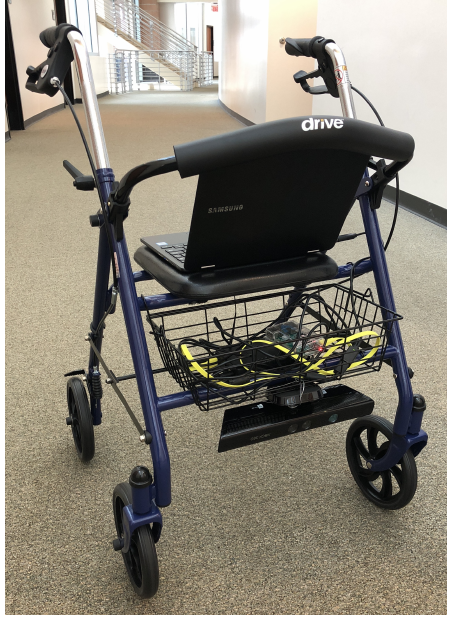
Figure 4. The smart walker in configuration D.